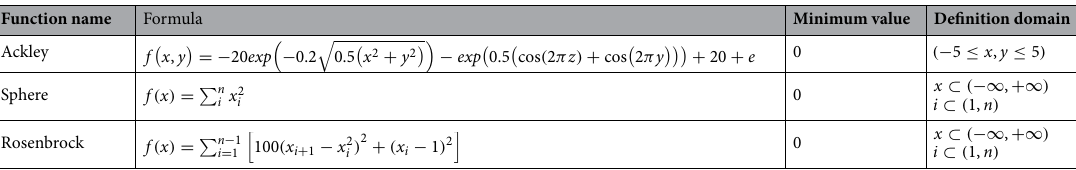
Table 2. The convergence test of the improved algorithm is tested using the test functions listed in the table.